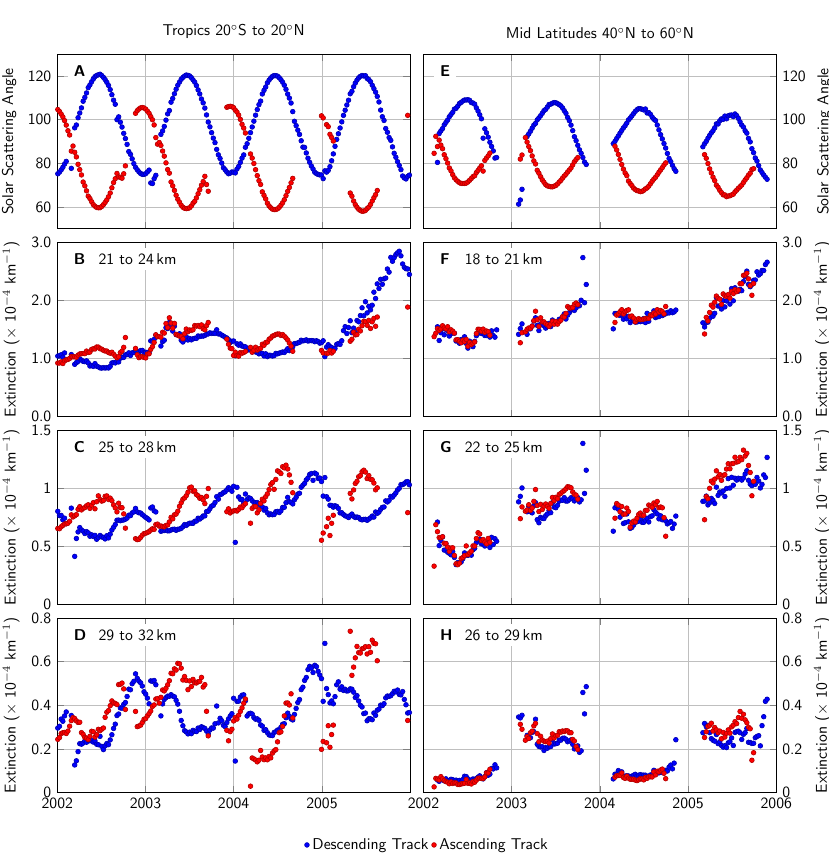
Fig. 2. Retrieved extinction on the ascending and descending measurement tracks. Panel (A) shows the weekly averaged solar scattering angle of the ascending and descending track measurements from 20 ◦ N to 20 ◦ S. Panel (E) shows the same results for 40 ◦ N to 60 ◦ N. Panels (B) through (D) show the retrieved extinction at various altitudes for the two measurement tracks in the tropics. Panels (F) through (H) show the same results for the mid-latitudes at slightly lower altitudes.